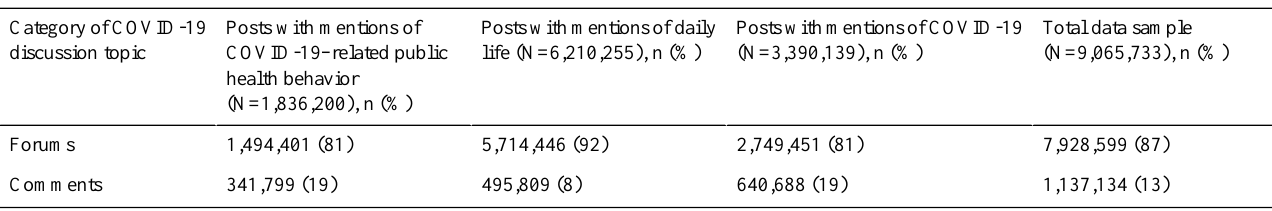
Table 2. Number of posts by source type from June 15 to November 15, 2020.